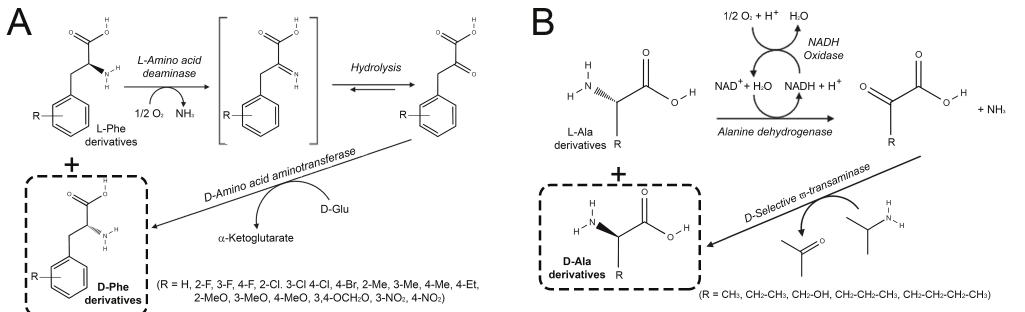
Figure 2. Stereoinversion and deracemization of: ( A ) phenylalanine derivatives by means of L-amino acid deaminase and a D-selective transaminase [18]; ( B ) alanine derivatives by alanine dehydrogenase from B. subtilis, NADH oxidase and the engineered D-selective ω -transaminase from Arthrobacter sp.